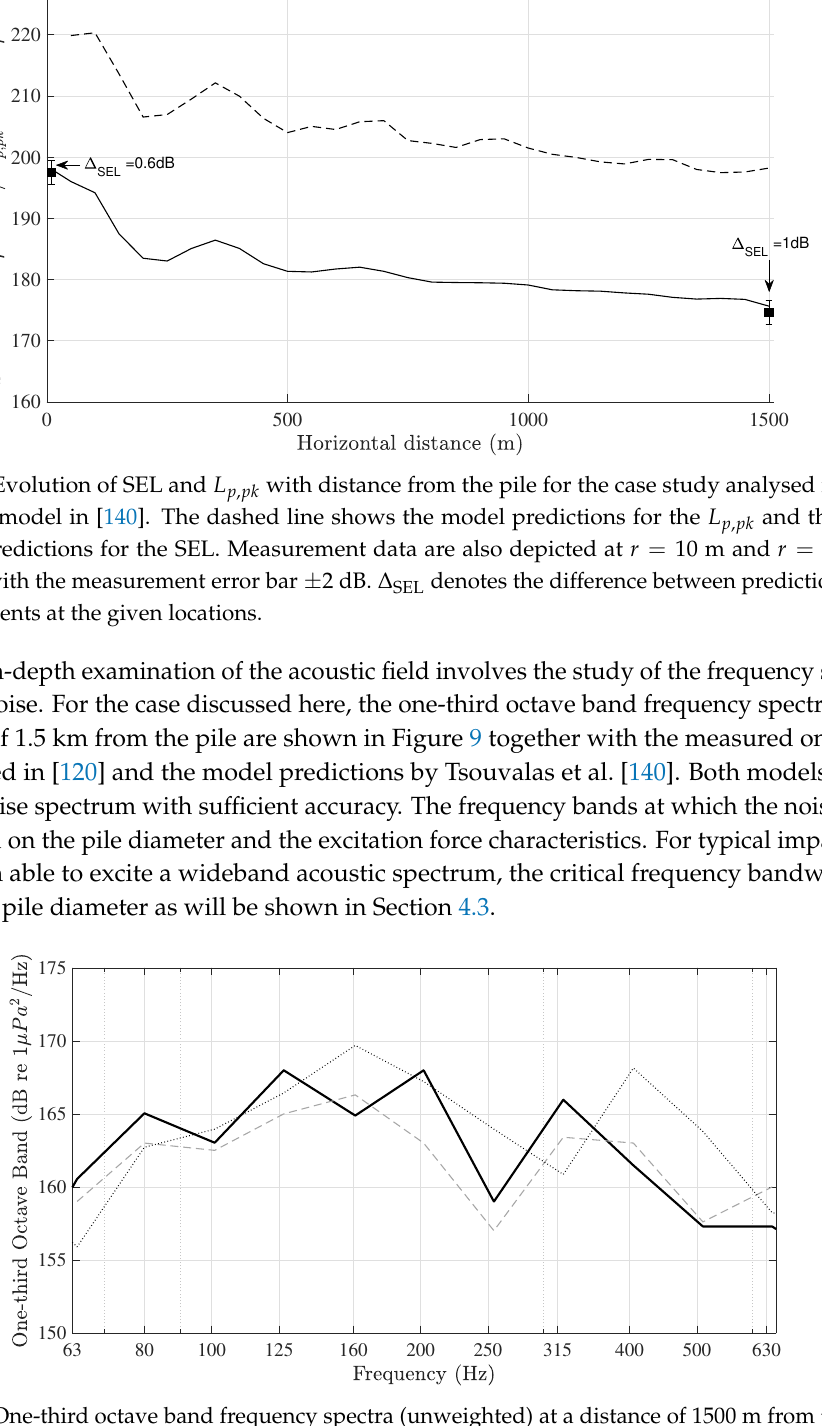
Figure 9. One-third octave band frequency spectra (unweighted) at a distance of 1500 m from the pile. The solid line represents measured data, the dashed line the model predictions using [140] and the dotted line the model predictions reported in